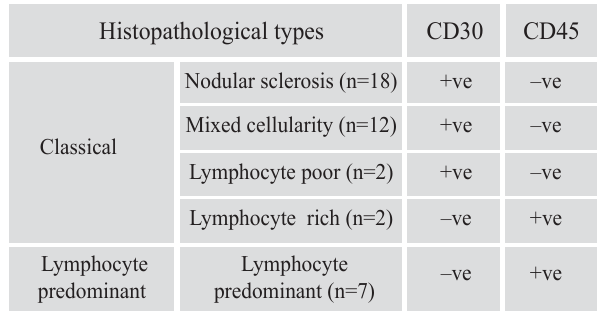
Table IV: Immunohistochemisty findings of